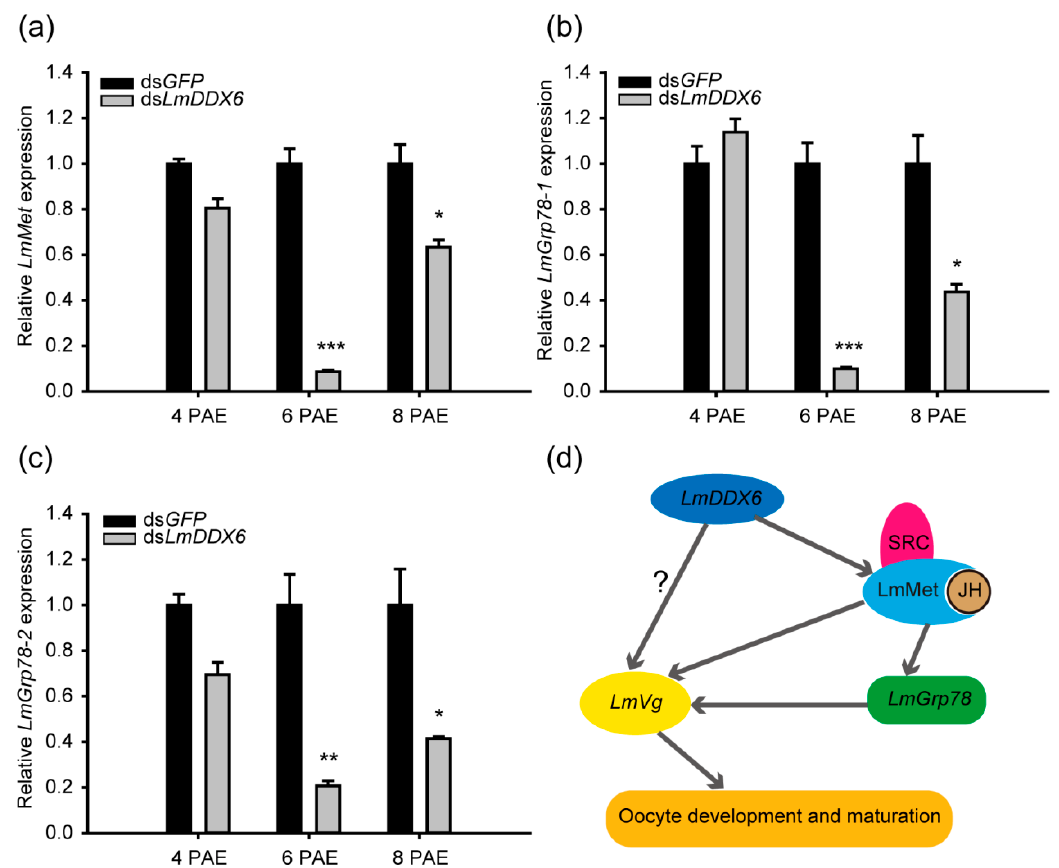
Figure 6. Sensitivity of Met , Grp78-1 , and Grp78-2 mRNA expression levels to LmDDX6 knockdown in the fat body of female adult locusts. ( a – c ) Effect of LmDDX6 knockdown on mRNA levels of LmMet ( a ), LmGrp78-1 ( b ), and LmGrp78-2 ( c ) in the fat body on days 4 – 8 PAE compared to the corresponding levels in ds GFP -injected locusts (negative control). Data are presented as the mean ± standard error of the mean ( n = 8 – 12). Statistical significance of differences is indicated as follows: * p < 0.05; ** p < 0.01; *** p < 0.001. ( d ) A proposed model for the role of LmDDX6 in locust oocyte development and maturation. LmDDX6 regulates the expression of LmVg directly or indirectly via the JH signaling pathway and, thus, promotes vitellogenesis and oocyte maturation in the